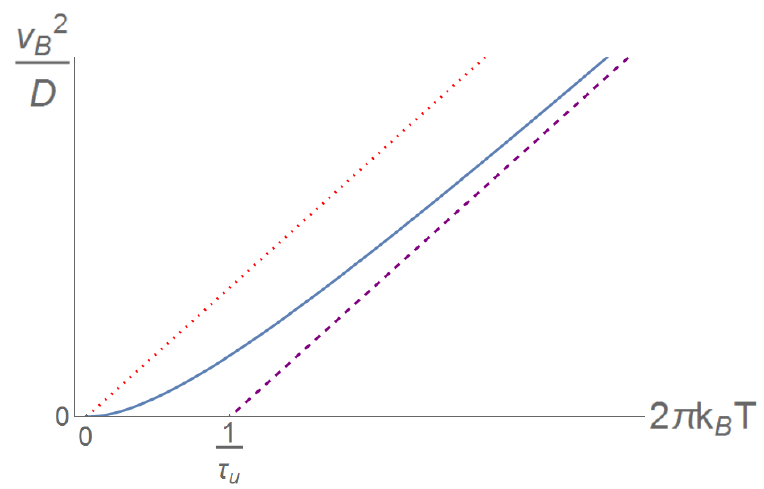
2 Figure 6 . A sketch of v (cid:0) T in this model. The dotted line represents the bound proposed in B D the refs. [70, 76{81]. The solid curve shows the result of eq. (3.33) and the dashed line gives its asymptotic behavior. The crossover occurs near T (cid:24) 1 =(cid:28) u .